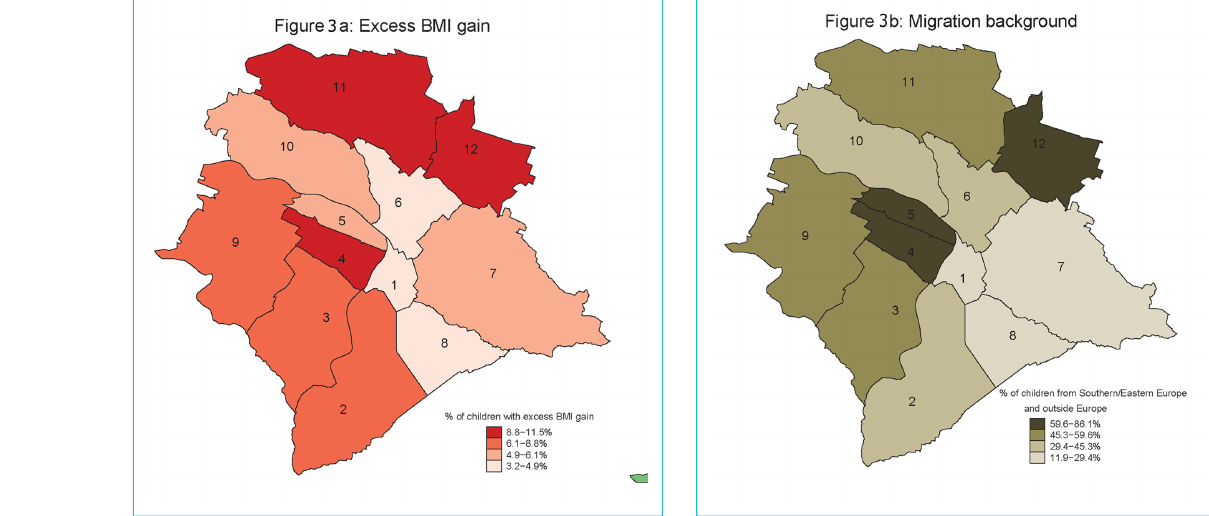
Figure 3a: Map of the City of Zurich showing the proportion of chil- dren with excess BMI gain in different districts (intensity of the